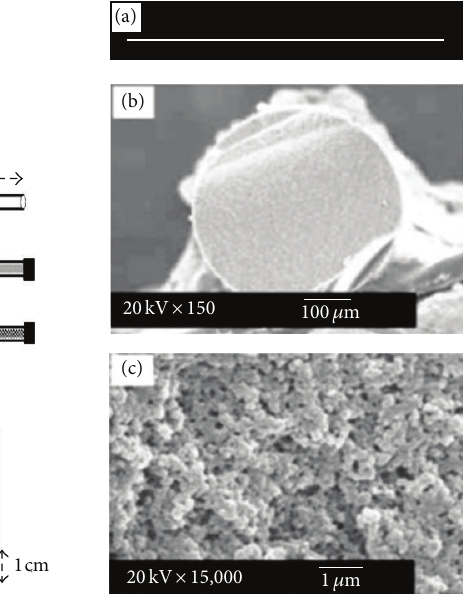
Figure 3: Schematic illustration of MIP preparation procedure